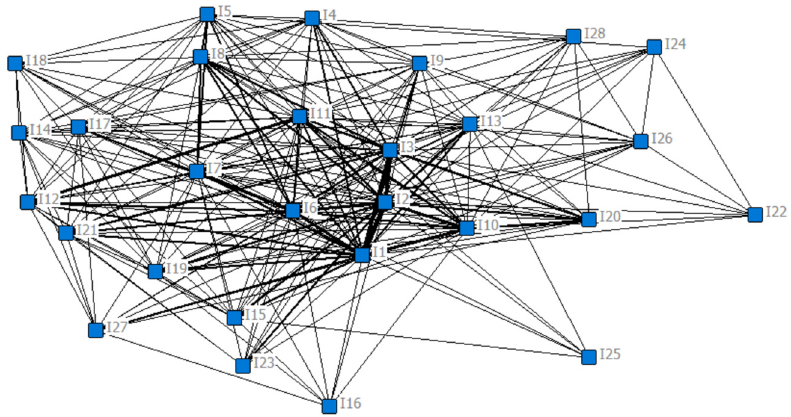
Figure 2. The social network of influencing factors of Chinese urban community function loss under flood disaster.